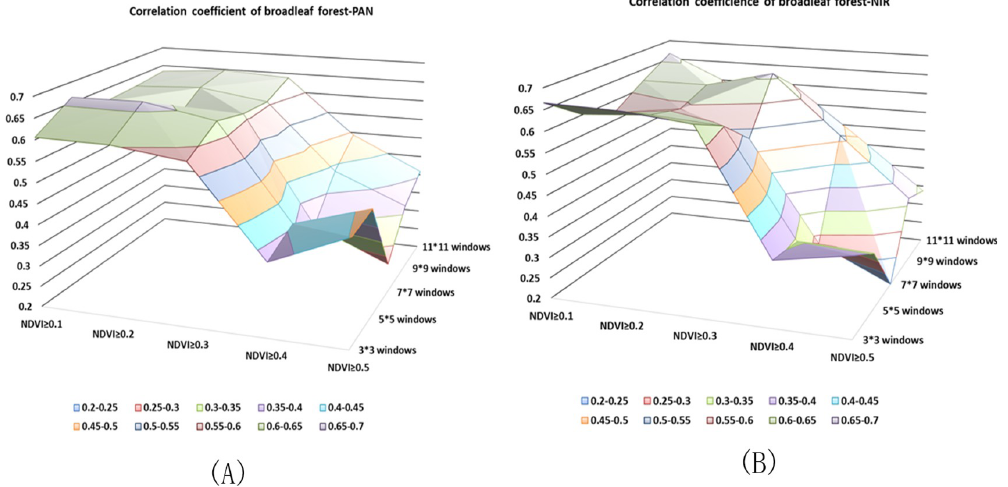
Fig 5. Correlation Coefficients of broadleaf stand between stand density based on different window size and NDVI threshold and true stand density. (A) Correlation coefficient of the PAN. (B) Correlation coefficient of the NIR.